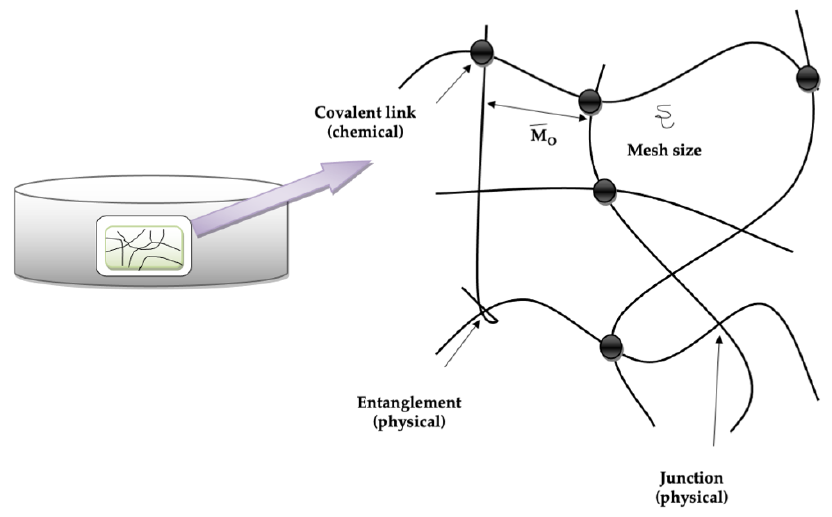
Figure 1. Hydrogel structural chemistry Figure 1 . Hydrogel structural chemistry [50].